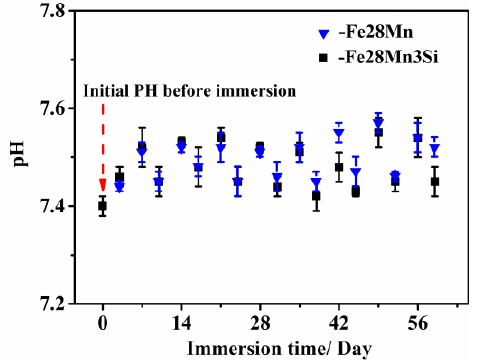
Figure 2. Comparison of pH over immersion duration for Fe–Mn-based alloys.